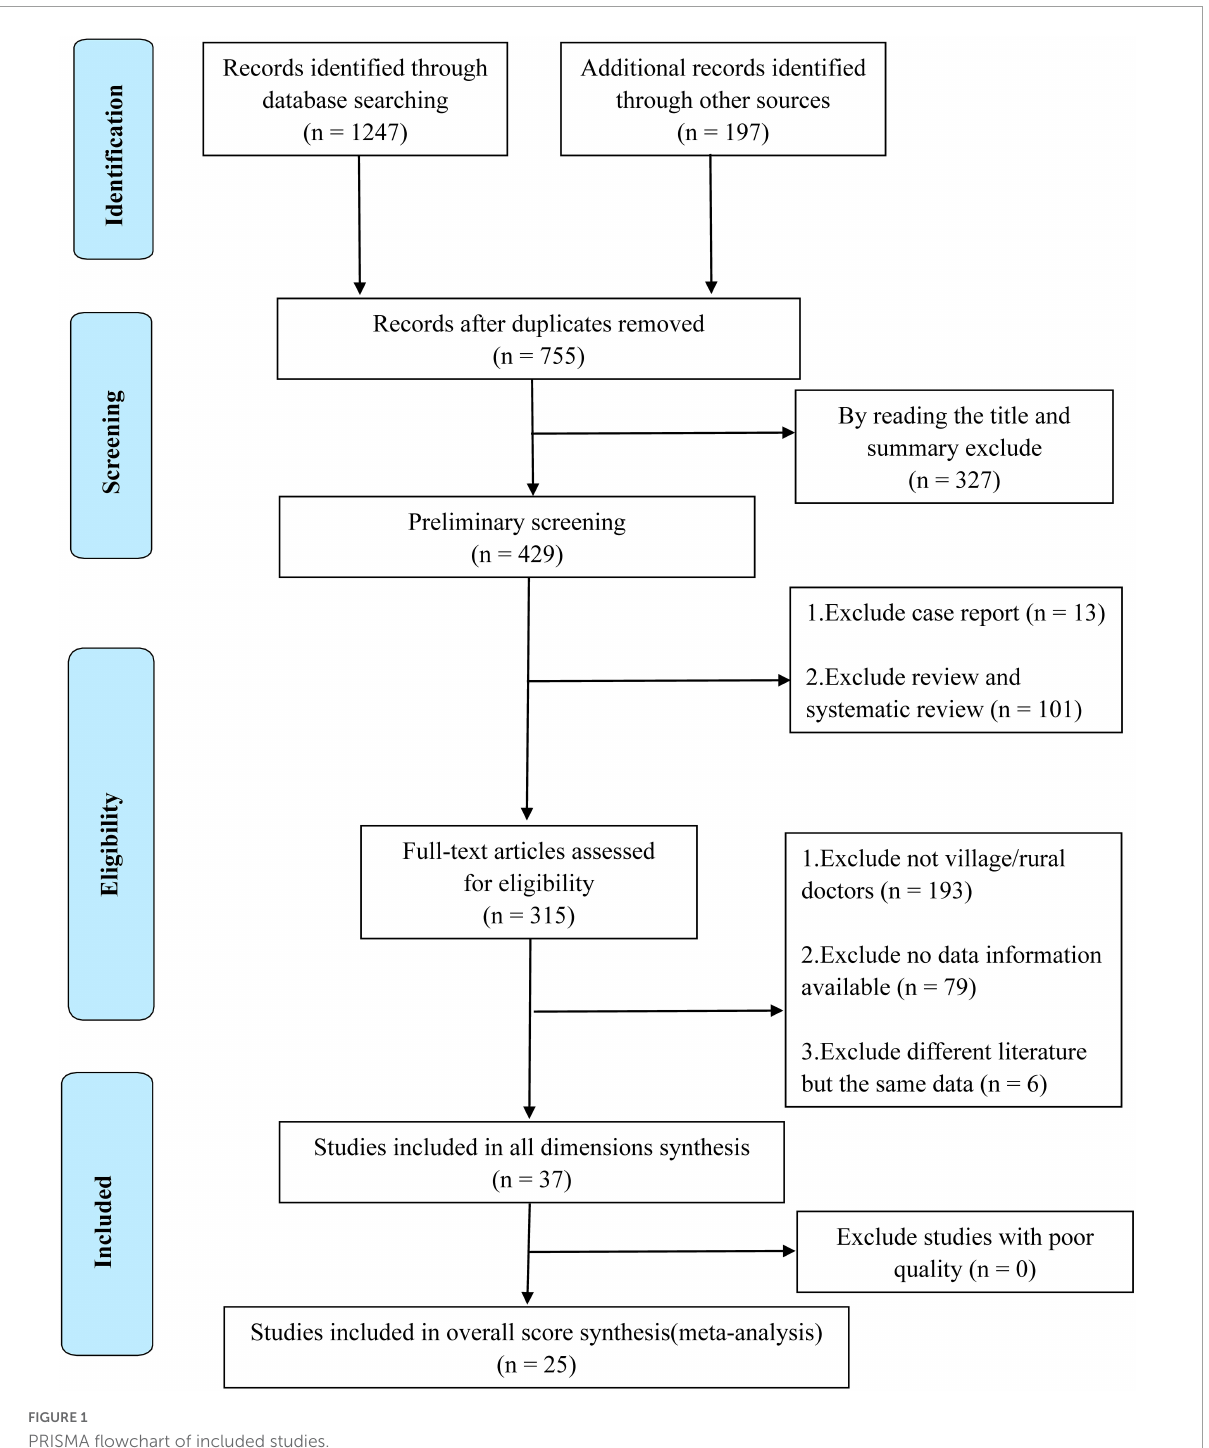
FIGURE1 PRISMA flowchart of included